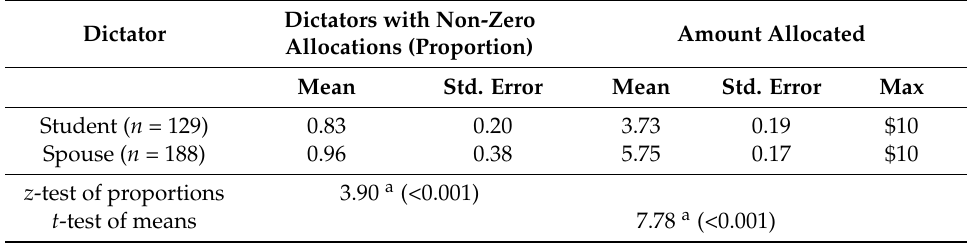
Figure 1. ( a ) Allocations by anonymous students ( n = 129). ( b ) Allocations by spouses ( n = 188). Table 3. Allocation of $10 to students and